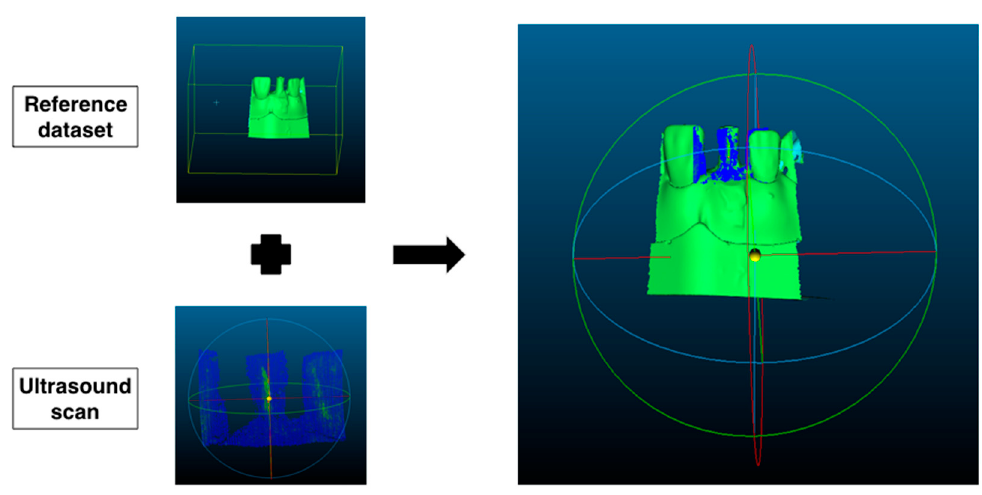
Figure 4. Test and reference datasets were aligned using manual and automatic methods to determine the closest common points. Manual alignment was performed by determining equivalent data points between data.